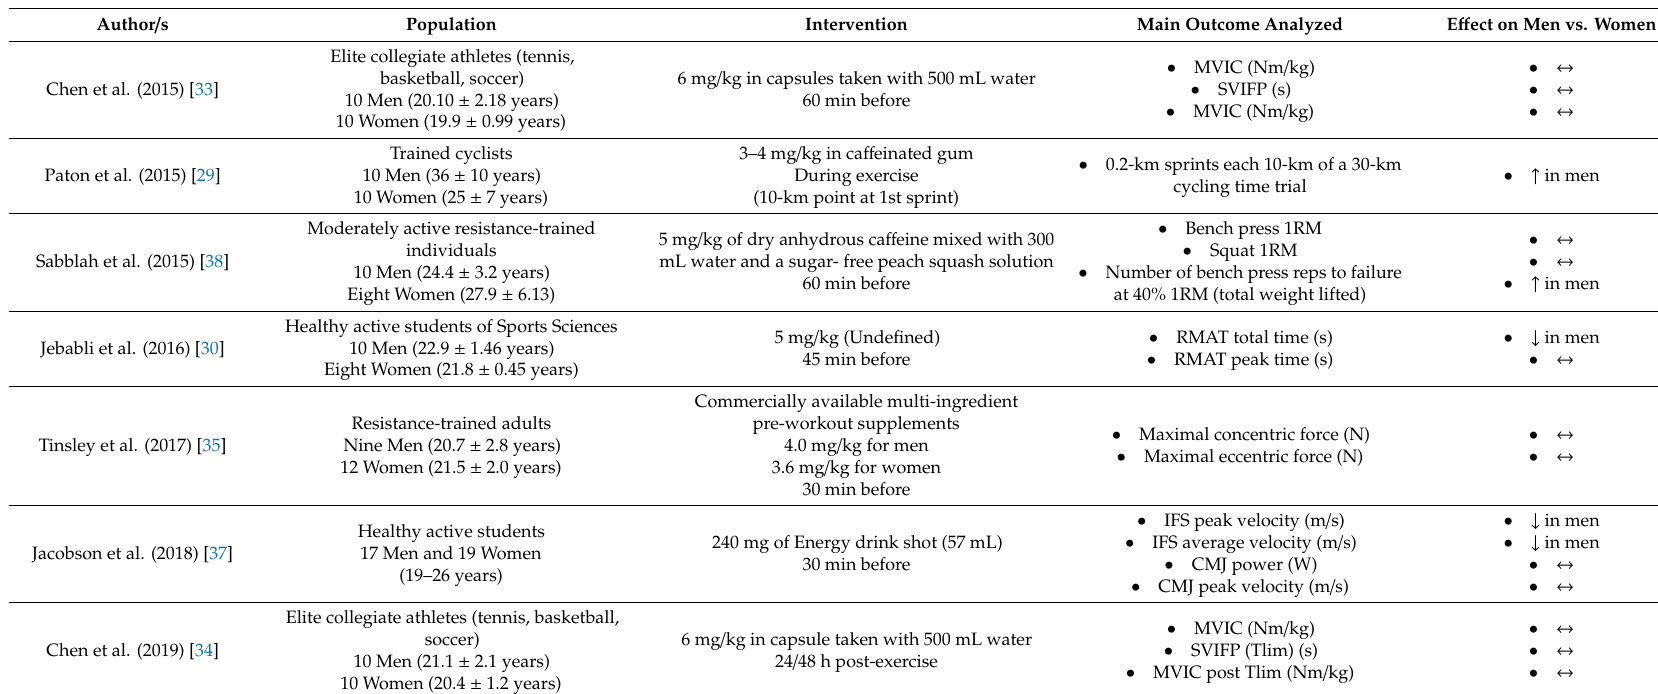
Table 2. Summary of studies included in the systematic review that investigated the e ff ect of ca ff eine ingestion between sexes on anaerobic